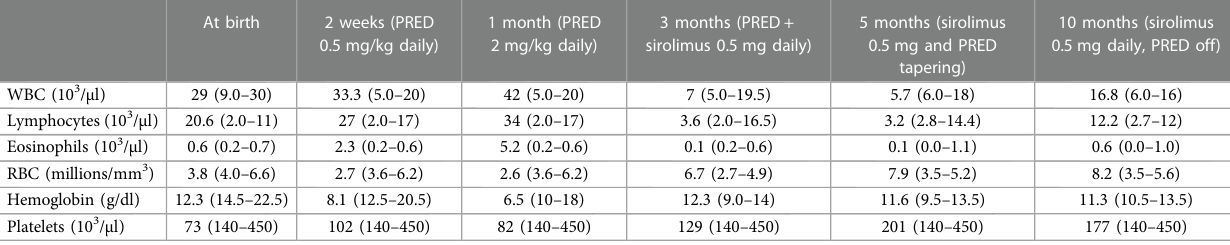
TABLE 1 A summary of complete blood count results at various time intervals following birth. At